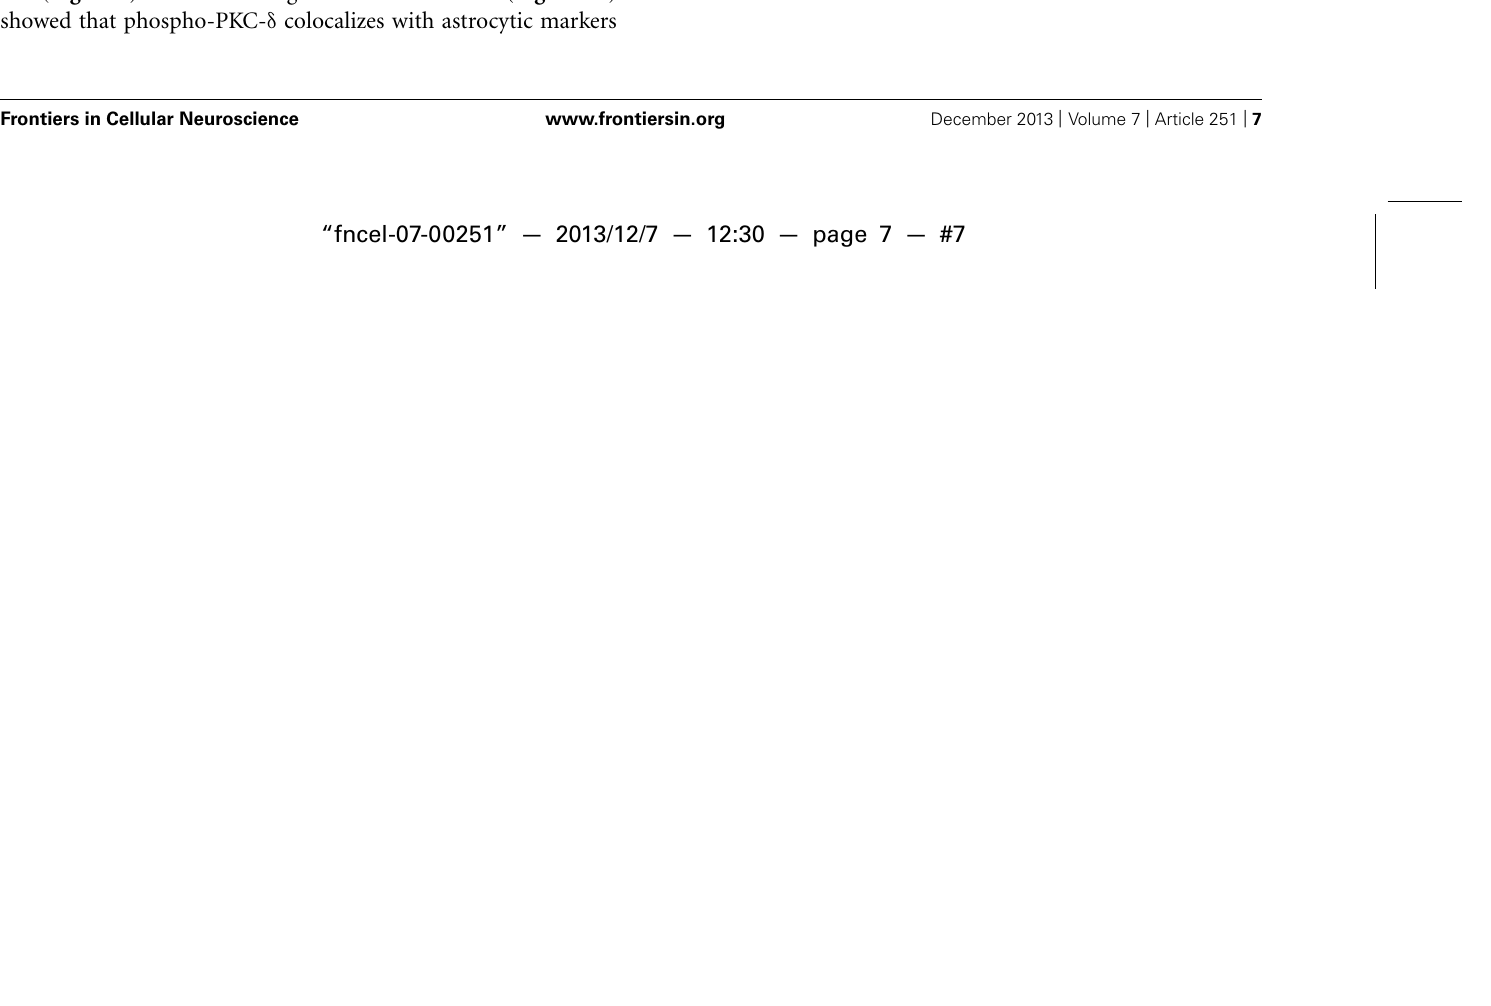
FIGURE 5 | Peripheral nerve injury induces the activation of PKC- δ , - θ and - ζ in the spinal cord. (A) Western blots showing phosphorylated PKC isoforms in the ipsilateral dorsal spinal cord of SNI and sham. (B) Bar graphs indicating the optical quantification of band intensity, as a ratio over Coomassie staining and normalized over sham, expressed as mean ± SEM. n.s., non significant; ** p < 0.01; *** p < 0.001 t -test, sham vs. SNI, n = 6 for each condition. A significant activation of PKC- δ , - θ and - ζ is